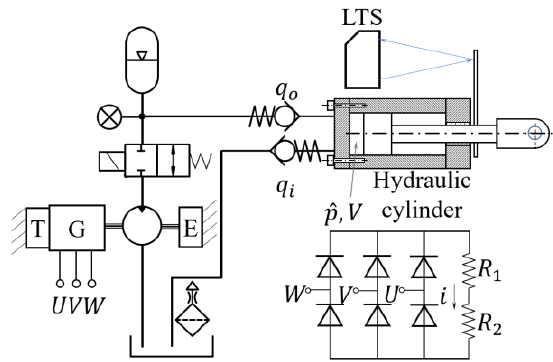
Figure 5. Circuit diagram of the experimental system. Note: T represents the torque transducer; G is the electric generator; E is the rotary encoder; and U, V, and W are the three winding coils of the generator.